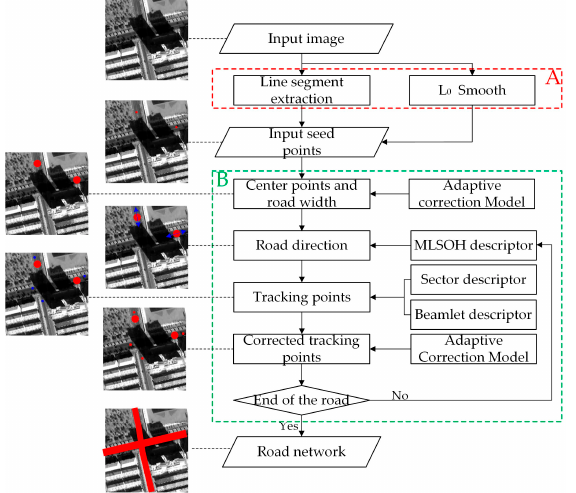
Figure 1. Flow chart.